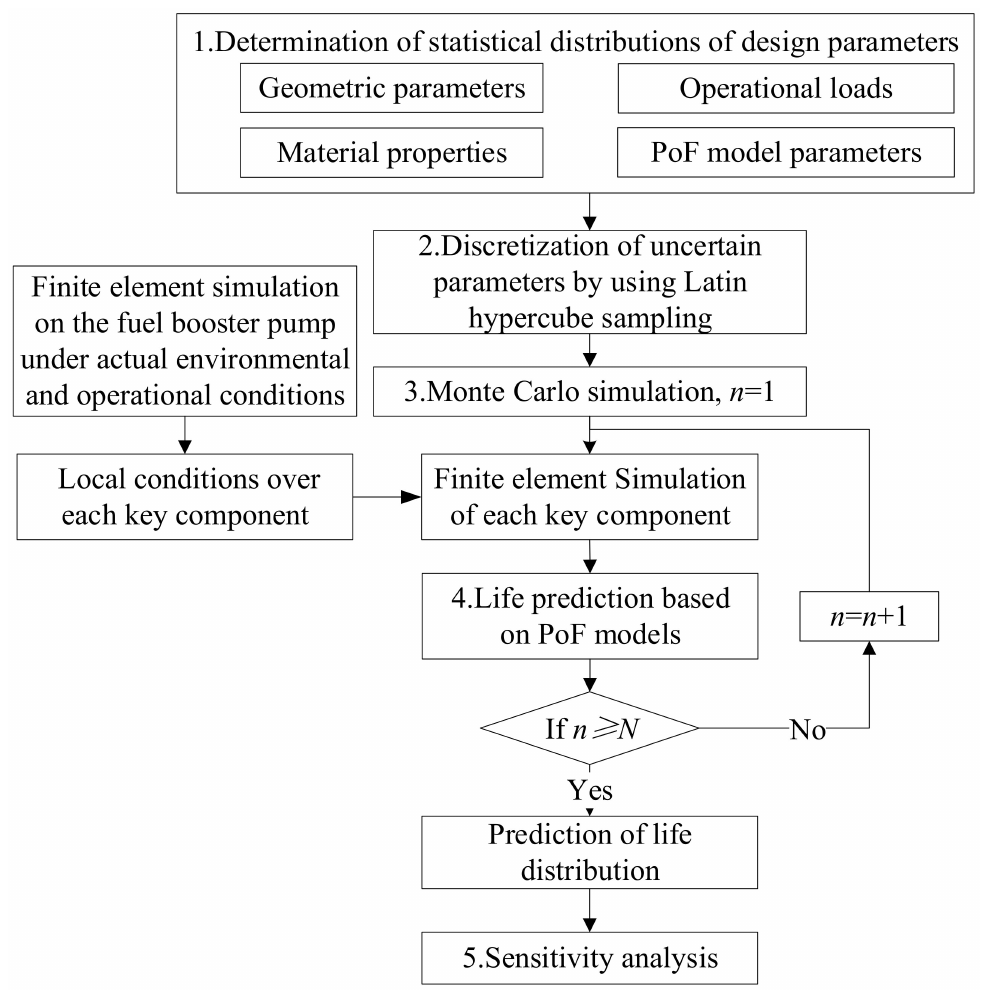
Figure 1. Procedure of the reliability simulation and sensitivity analysis for each key